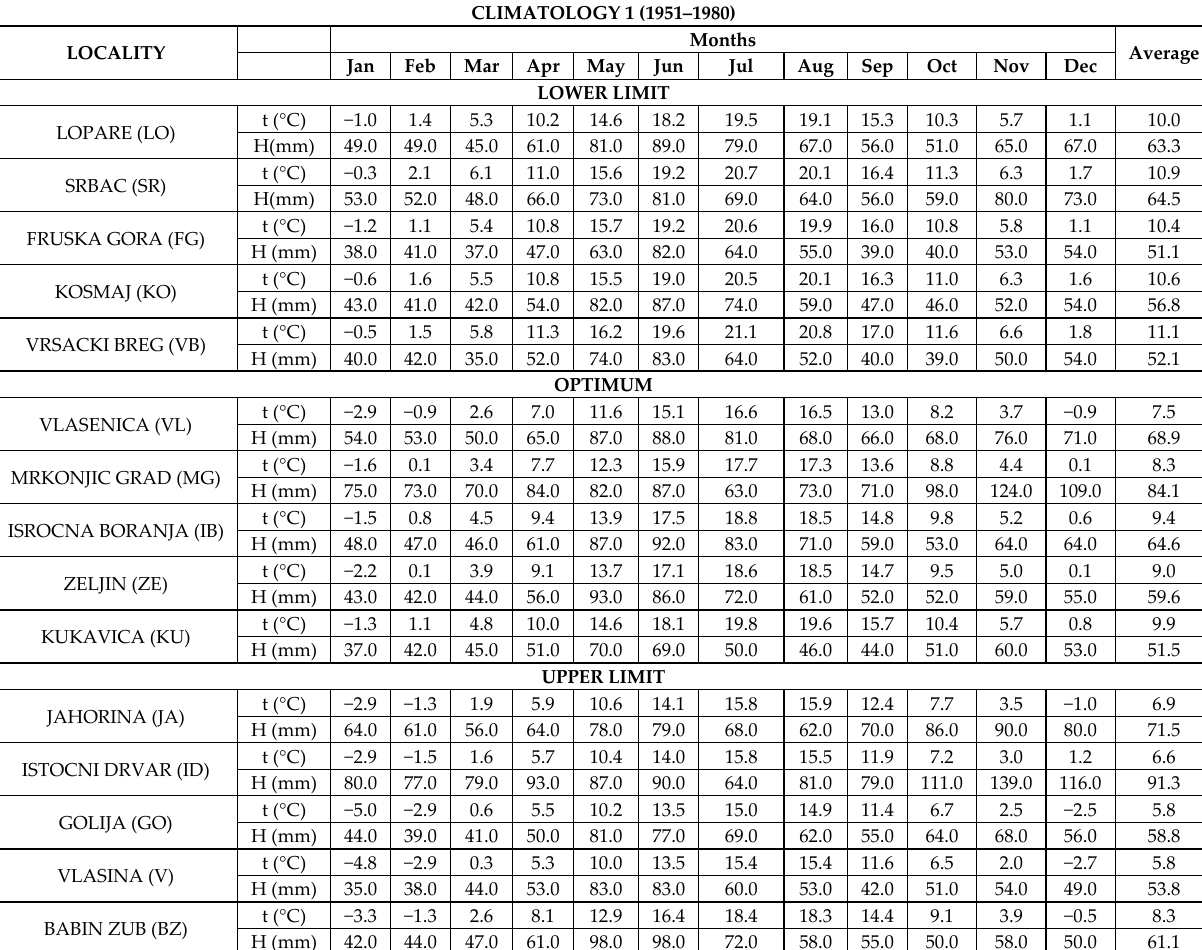
Table A1. Normal temperatures and average annual precipitation on sampling sites for the 1951–1980 reference climatology.